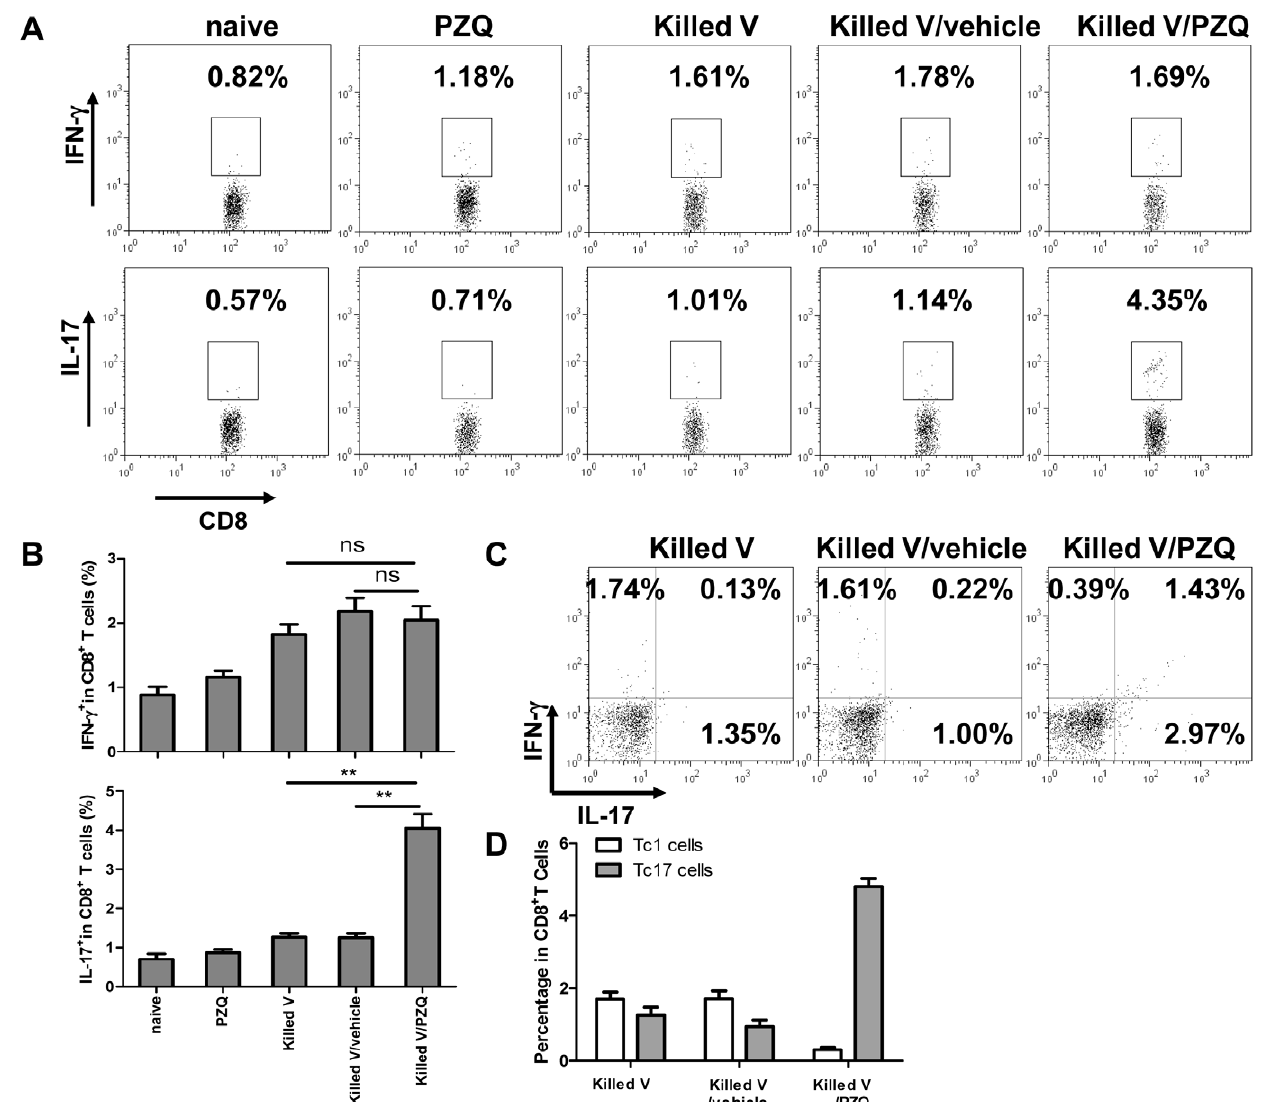
Figure 2. Analysis of antigen-specific cytokine productions in CD8 + T cells. Splenic cells were isolated from C57BL/6 mice on day 7 after immunization and stimulated with NP peptide for 6 h in culture. (A) Intracellular staining for IFN- c , IL-17 and CD8 + was analyzed by FACS. (B) The percentages of positive-stained cells are summarized as the means from three independent experiments. (C) Co-staining for IFN- c and IL-17 in CD8 + T cells. (D) The percentages were shown as the means of three independent experiments. **, p , 0.01. ns, p . 0.05.